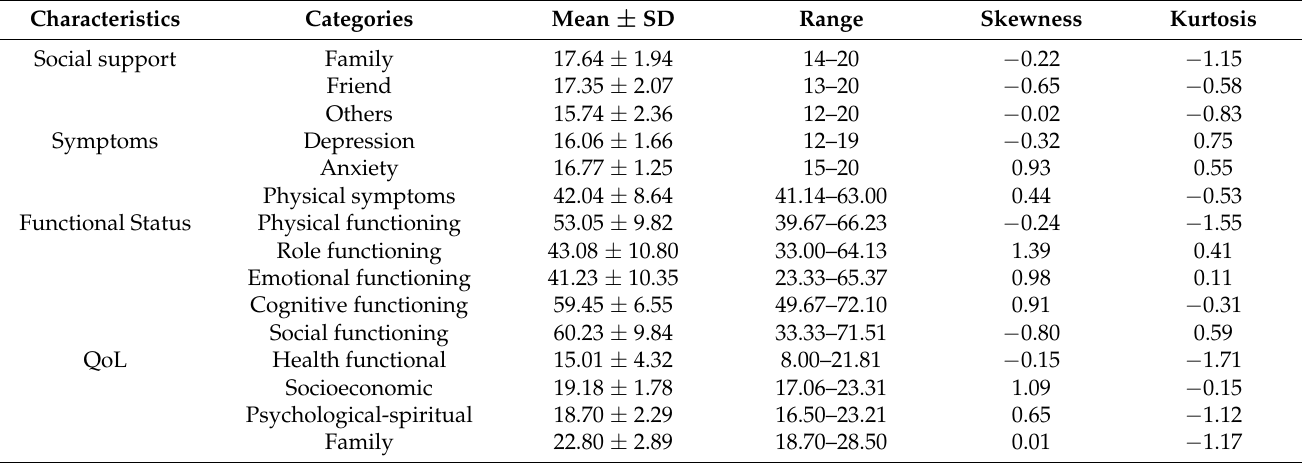
Table 2. Descriptive statistics of the main variables (N = 248).